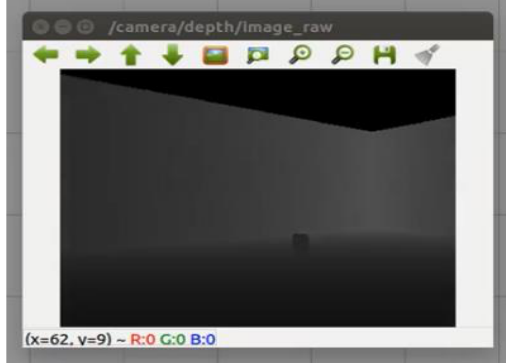
Figure 11. The depth image of the target object from an RGB−D camera. The average cumulative reward over 100 batch size received by a DQN agent in the Gazebo simulator after training the mobile robot for 150,000 time steps is shown in Figure 12. The average cumulative TD error over 100 batch size of a DQN agent in the Gazebo simulator after training the mobile robot for 150,000 time steps is shown in Figure 13. The average cumulative reward over 100 batch size received by a DQN agent in the Gazebo simulator after training the mobile robot for 150,000 time steps for different discount fac- tor values is shown in Figure 14. The average cumulative reward over 100 batch size re- ceived by a DDQN agent in the Gazebo simulator after training the mobile robot for 150,000 time steps is shown in Figure 15. The average cumulative TD error over 100 batch size of a DDQN agent in the Gazebo simulator after training the mobile robot for 150,000 time steps is shown in Figure 16. Finally, the average cumulative reward over 100 batch size received by a DDQN agent in the Gazebo simulator after training the mobile robot for 150,000 time steps for different discount factor values is shown in Figure 17. Figure 12. Average cumulative reward obtained by a DQN agent in the Gazebo simulator. Figure 13. Average cumulative TD error of a DQN agent in the Gazebo simulator. 300,000 200,000 100,000 − 100,0000 T D e rr o r